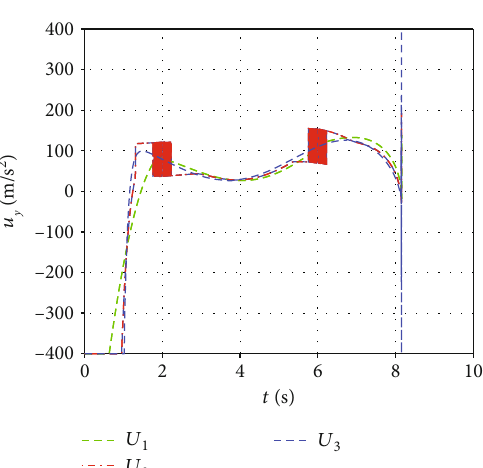
Figure 50: Target acceleration estimation in the lateral . y